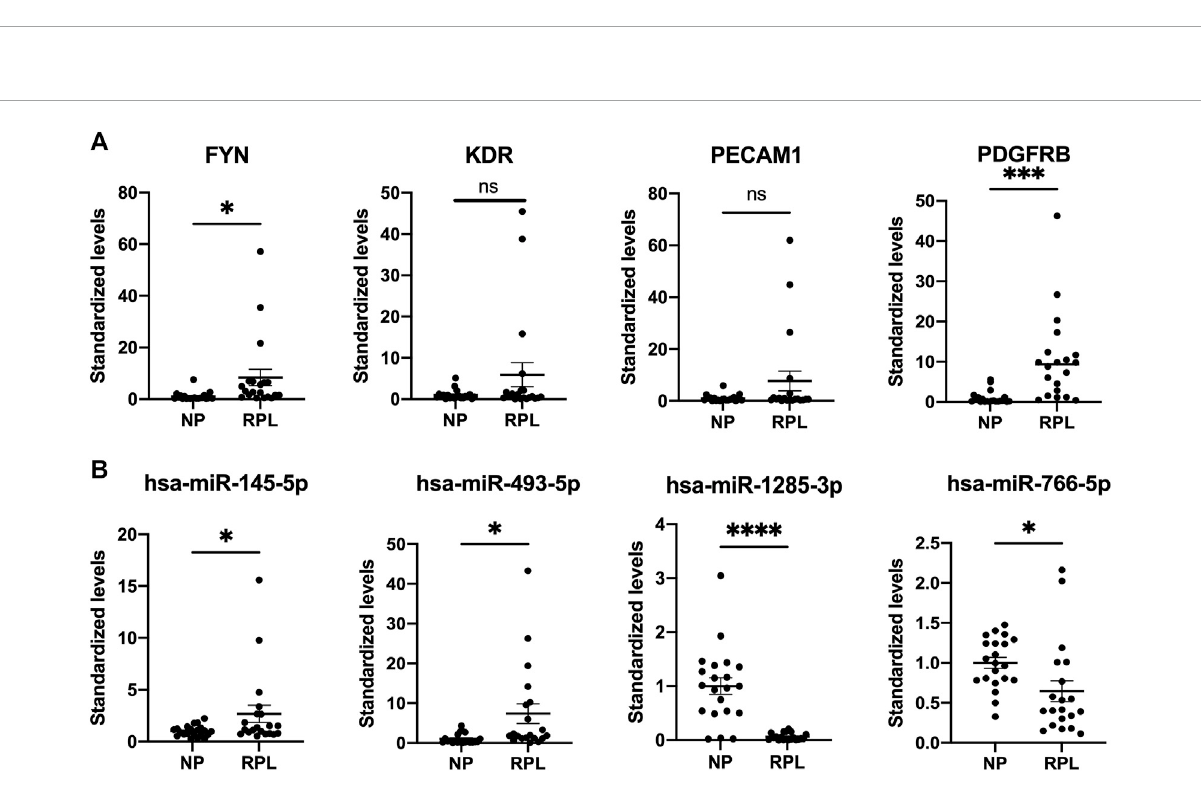
FIGURE 8 Validation of placental mRNAs and circulating miRNAs in the NP and RPL groups. mRNAs (A) and miRNAs (B) were con fi rmed by qPCR. The expressiontrendsofcandidatemRNAsandmiRNAswereconsistentwiththesequencingresults.Dataarepresentedas2 − ΔΔ